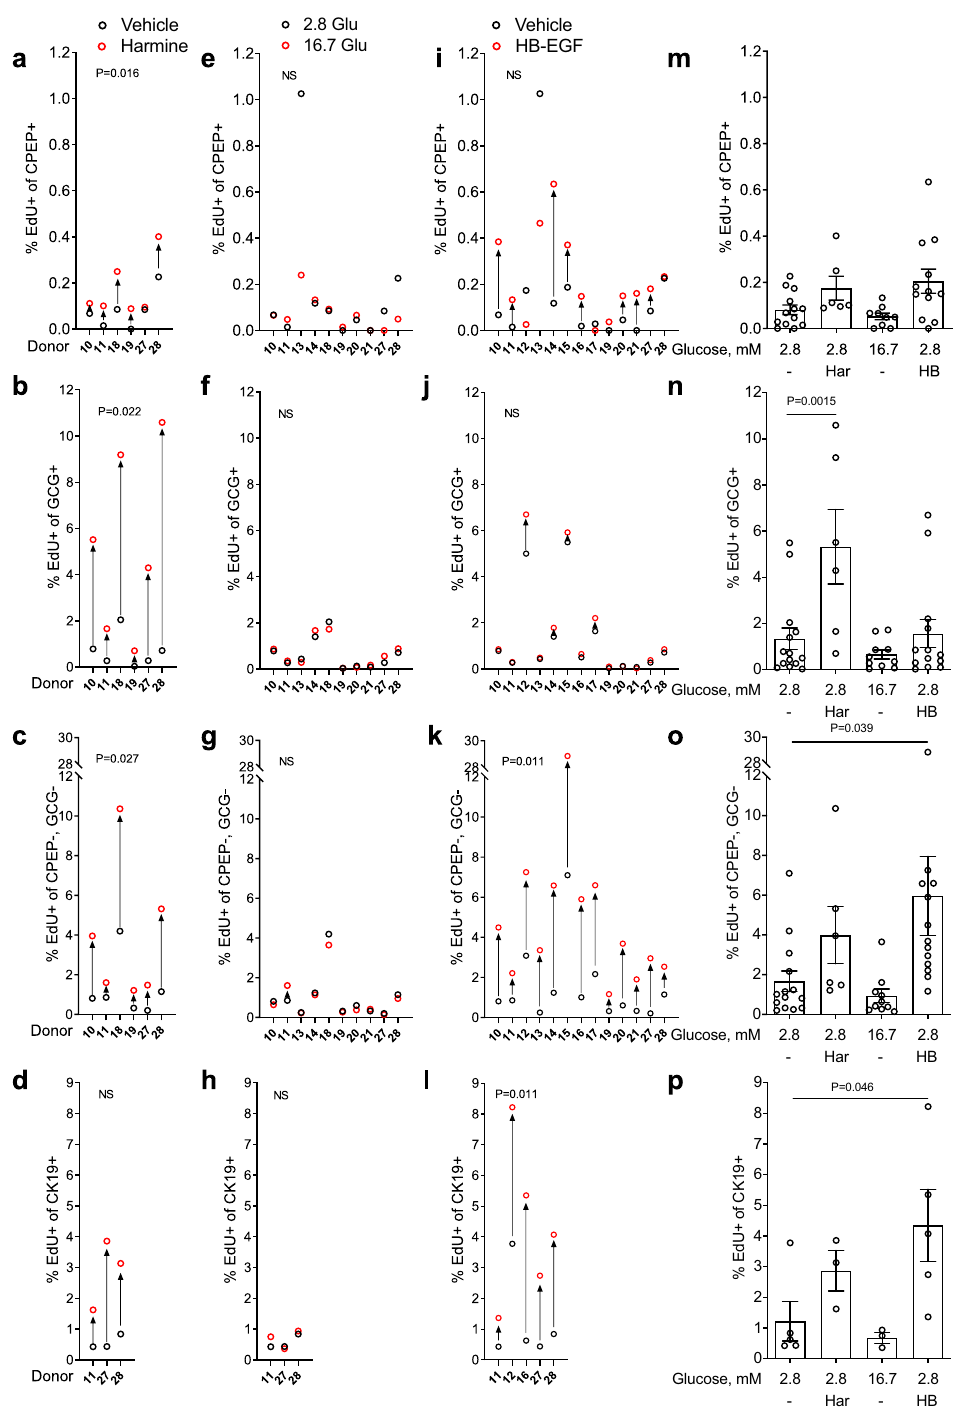
Figure 6. Analysis of cell proliferation in intact human islets by flow cytometry. ( a – p ) Intact human islets were exposed to 2.8 mM glucose (Vehicle or 2.8 Glu; a – p ), harmine (10 μM) (Har; a – d , m – p ), 16.7 mM glucose (16.7 Glu; e – h , m – p ) and HB-EGF (100 ng/ml) (HB; i – l , m – p ) for 72 h. EdU (10 μM) was added throughout. At the end of the treatment islets were dispersed into single cells and analyzed by flow cytometry for C-peptide (CPEP), glucagon (GCG), cytokeratin 19 (CK19) and EdU. A minimum of 2000 CPEP + , GCG + , GCG − / CPEP − and CK19 + cells were counted for each sample. Proliferation is presented as the percentage of EdU + cells over the total cells for each of CPEP + ( a , e , i , m ), GCG + ( b , f , j , n ), CPEP − , GCG − ( c , g , k , o ) and CK19 + ( d , h , l , p ) cell types. Graphs showing cell proliferation of individual ( a – l ) and combined ( m – p ) donors were generated using GraphPad Prism 9 software (https:// www. graph pad. com/ scien tific- softw are/ prism/). Donor identifiers (Supplementary Table S1 online) are indicated. Significance was tested using paired t tests ( a – l ) and one-way ANOVA ( m – p ). P < 0.05 was considered significant. NS, not